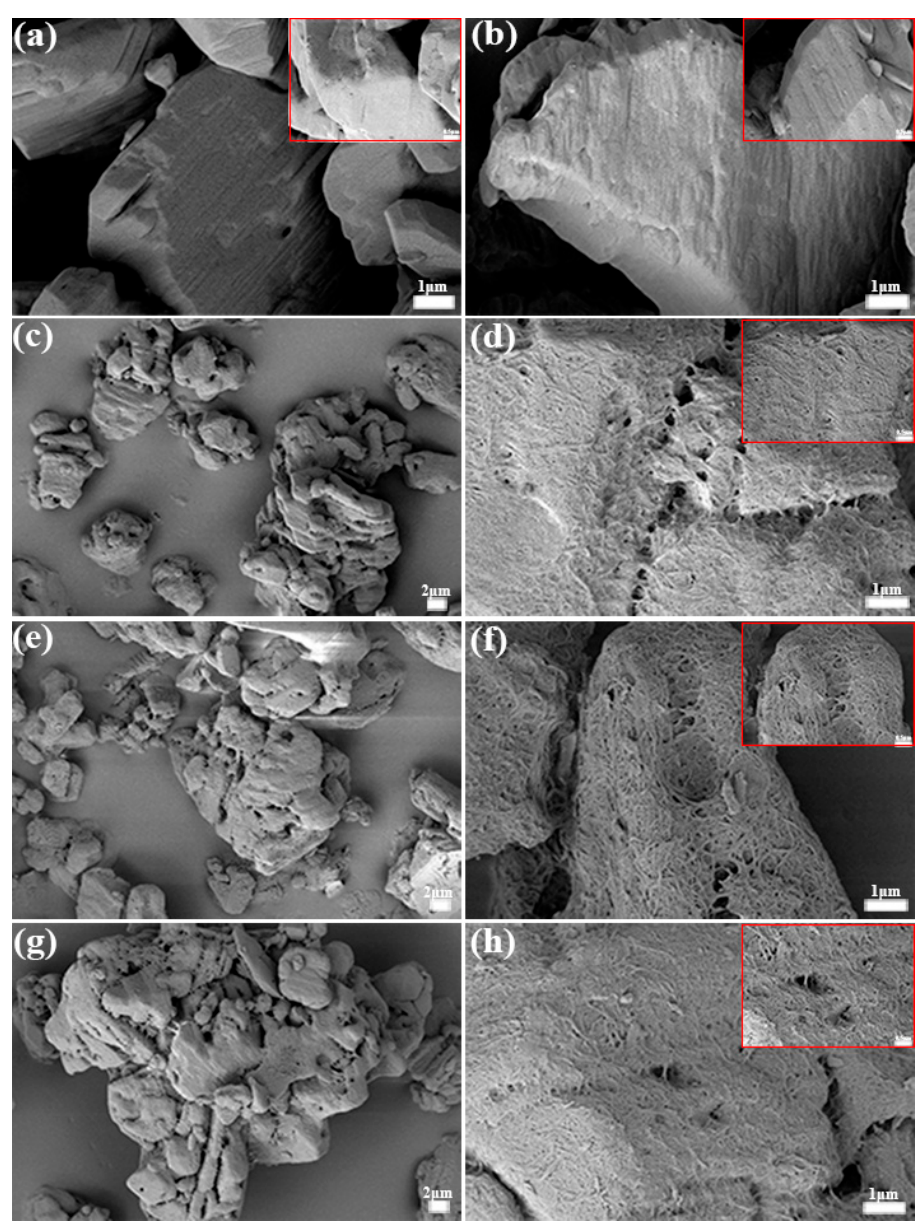
Figure 2. SEM images for ( a ) pristine 1,3,5-triamino-2,4,6-trinitrobenzene (TATB), ( b ) polydopamine (PDA)-coated TATB, and PDA-coated TATB with ( c ) glycidyl azide polymer (TPG), ( e ) polytetramethylene ether glycol (TPP), and ( g ) polyethylene (TPE). ( d,f,h ) (including the corresponding inserts) high-magnification images for the surfaces of modified TATB shown in ( c,e,g ), respectively.